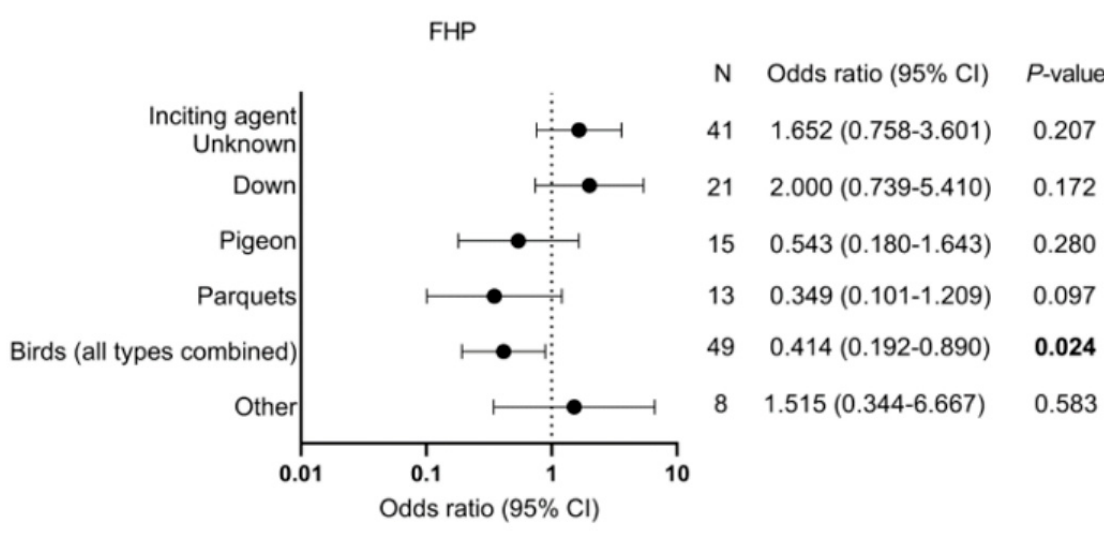
Figure 5. Type of inciting agents and risk for PPF. FHP: Fibrotic hypersensitivity pneumonitis and PPF: Progressive pulmonary fibrosis.